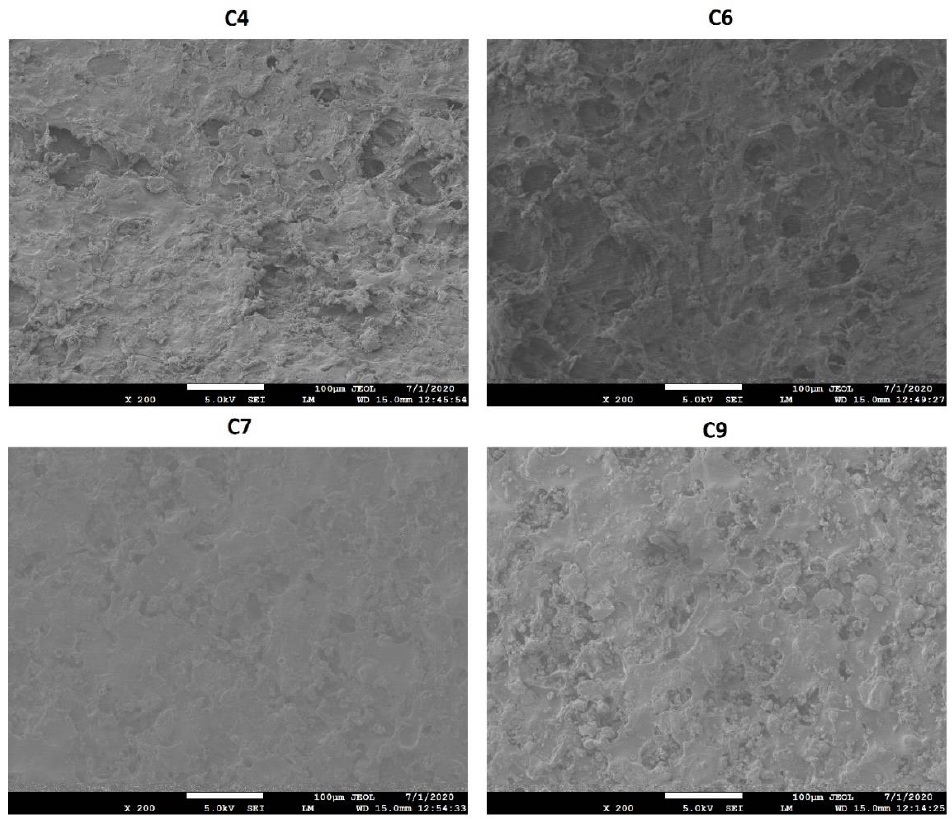
Figure 6. Surface morphology of shell of the tablets coated with blends of CAB 171-15/C-A-P blend after dissolution test.